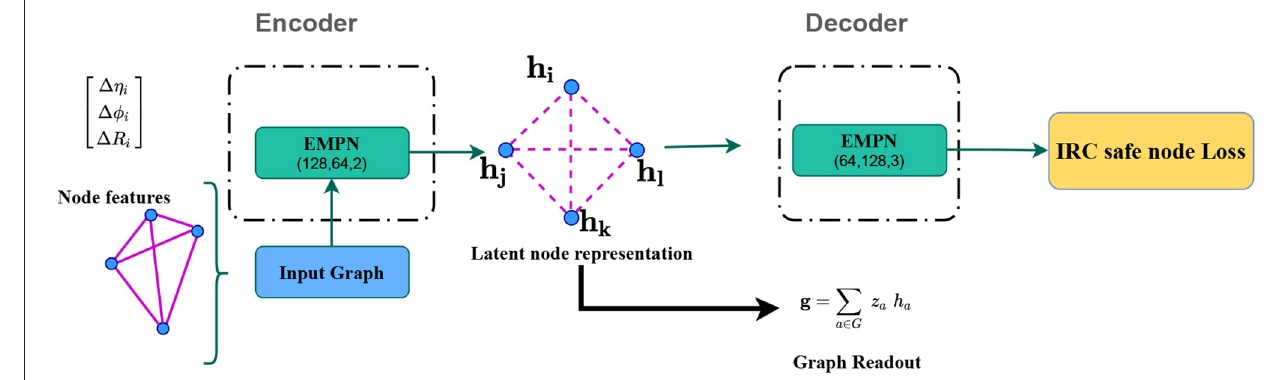
FIGURE 2 | A schematic diagram of an IRC safe graph-autoencoder.